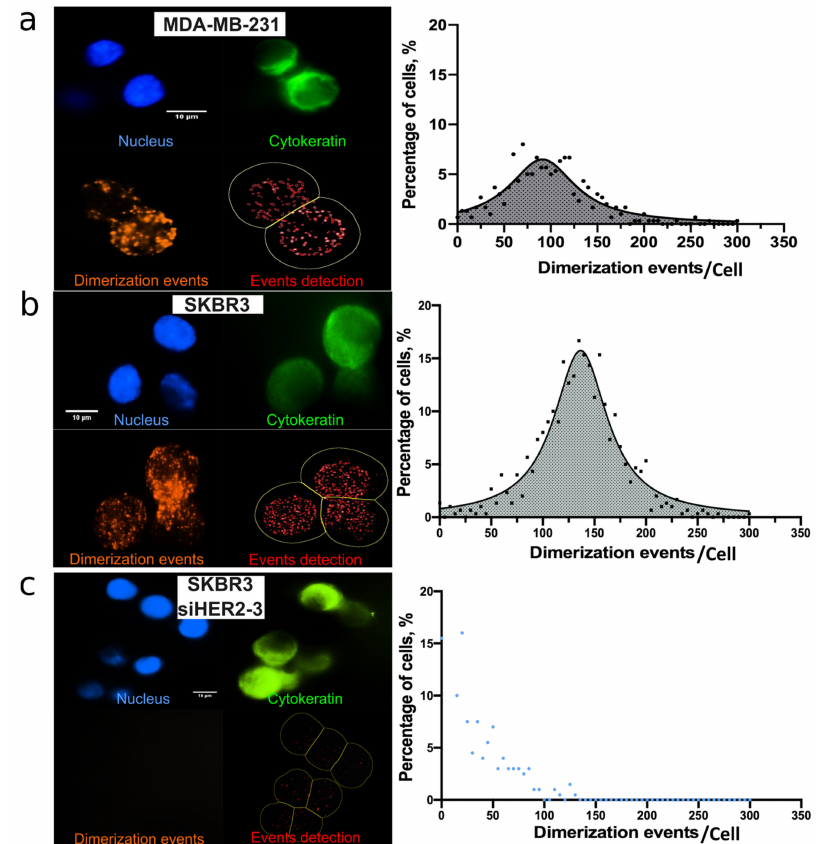
Figure 3. Left panel: On-chip immunofluorescence images of ( a ) MDA-MB-231 cells and ( b ) SK- BR-3 cells captured inside Ephesia showing PLA signals (left panel, orange). ( c ) HER2/HER3 gene silencing in SK-BR-3 cells induced a decreased in PLA signals, represented by the blue Gaussian curve shifted to the left. Right panel: Graphs quantifying the dimerization events per cell (bottom right, red) in each condition. n = 3 independent experiments for each condition. Scale bar: 10 µ